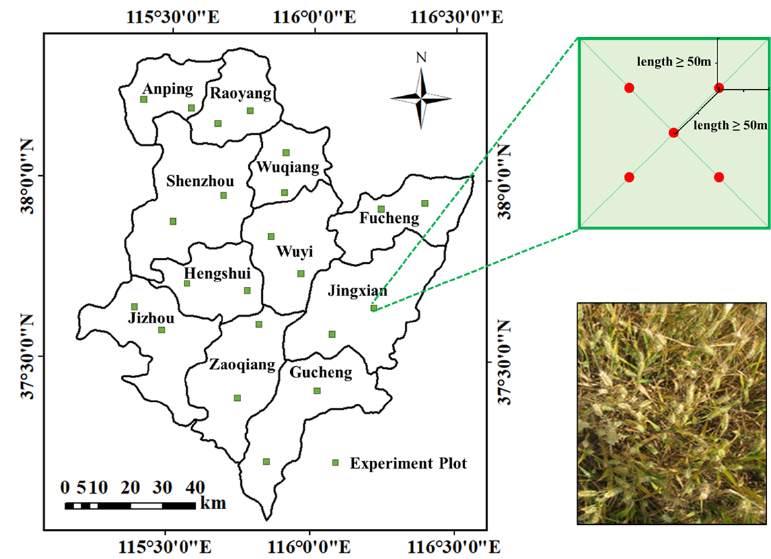
Figure 1. Experiment locations.